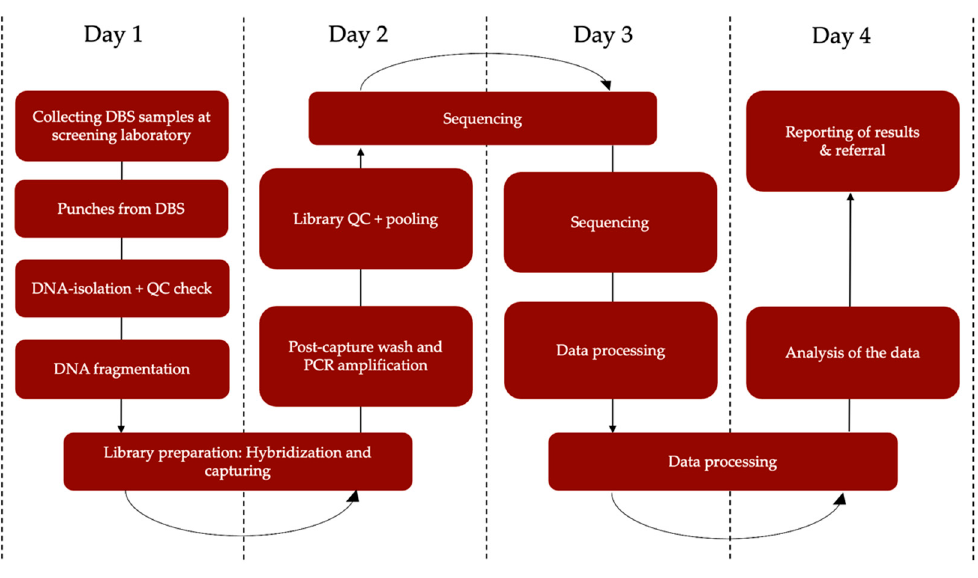
Figure 3. Estimated turn-around-time from NGS to result. DBS = dried blood spot, QC = quality control, PCR = polymerase chain reaction.